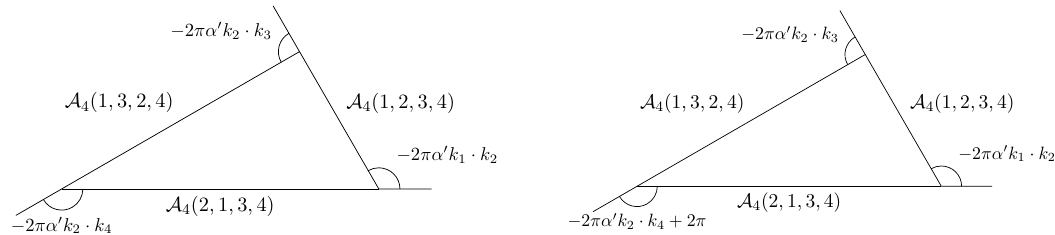
Figure 1. Triangle representing the 4-point tachyon amplitudes (left) and gauge amplitudes (right) from the Plahte